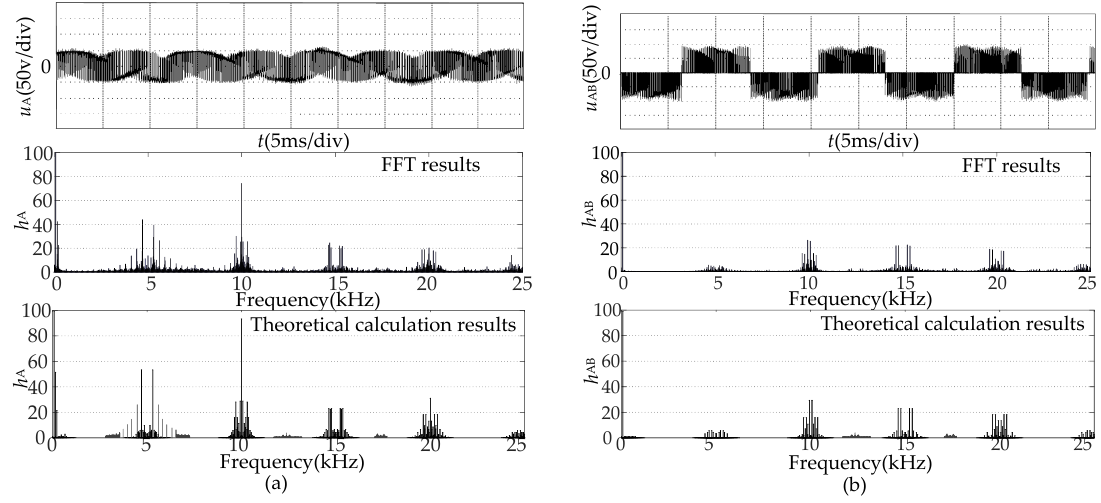
Figure 9. Time domain waveforms of output voltage and their spectrum ( m = 0.5, f in = 50 Hz, f out = 70.5 Hz, f c = 5 kHz) ( a ) u A and its spectrum ( b ) u AB and its spectrum.